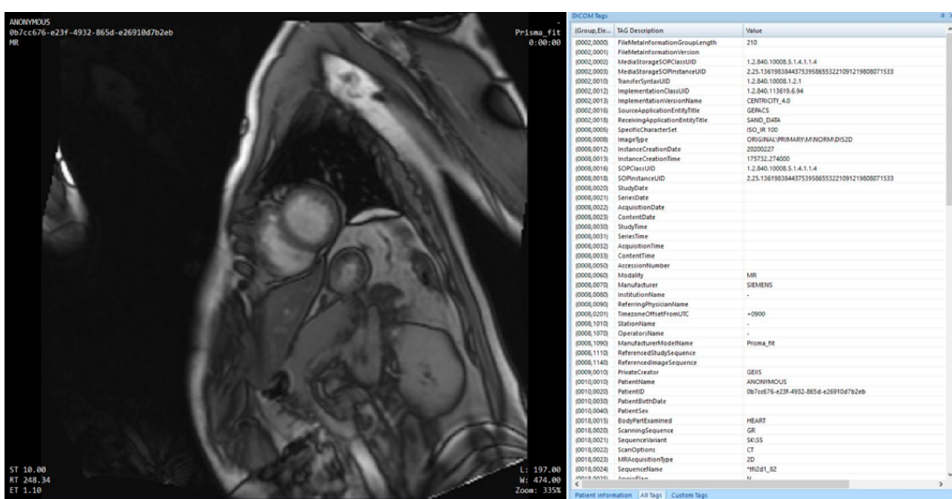
Figure 11. Results of Cardiovascular MRI Imaging with De-identifying Methods.